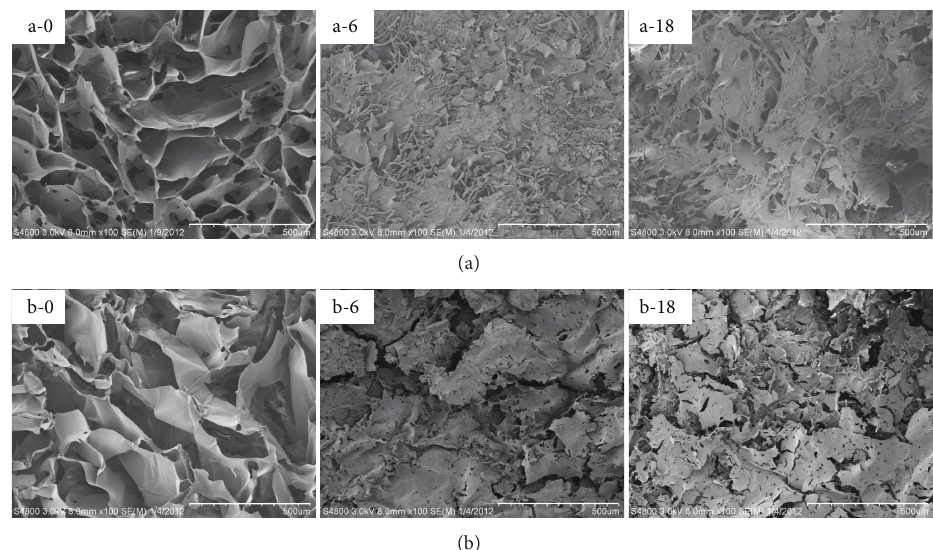
Figure 7: SEM images of scaffolds incubated in the enzymatic solution for 0, 6, and 18 days (a) unmodified; (b) modified (Scale bars = 500 𝜇